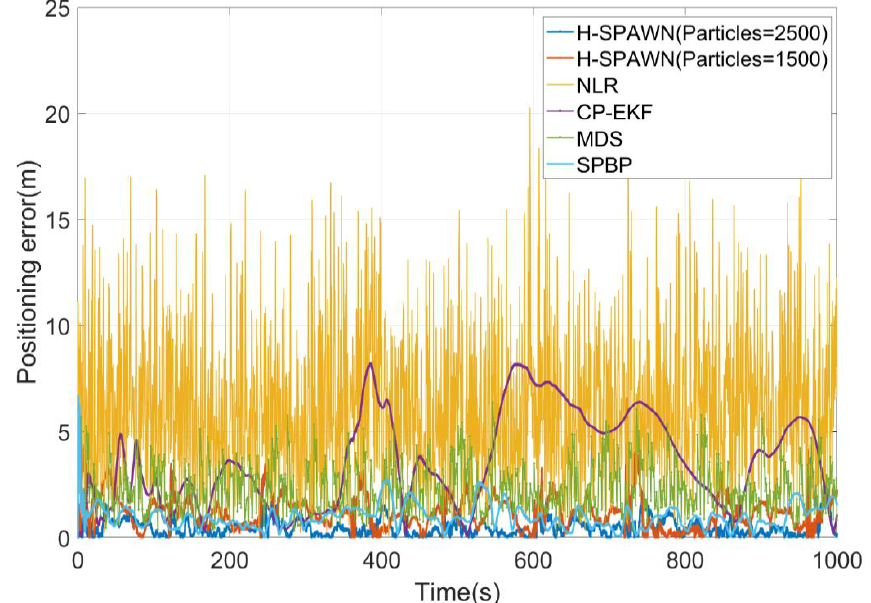
Figure 7. The example performance of positioning error for a single UAV: H-SPAWN (particle num- ber = 2500), H-SPAWN (particle number = 1500), NLR, CP-EKF, MDS, SPBP. number = 2500), H-SPAWN (particle number = 1500), NLR, CP-EKF, MDS,